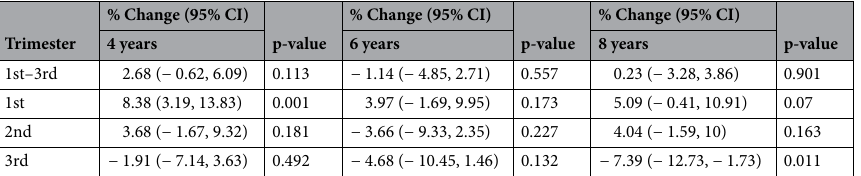
CpGs Chr Gene Gene group Relation to CpG island Estimate p-value (BH corrected